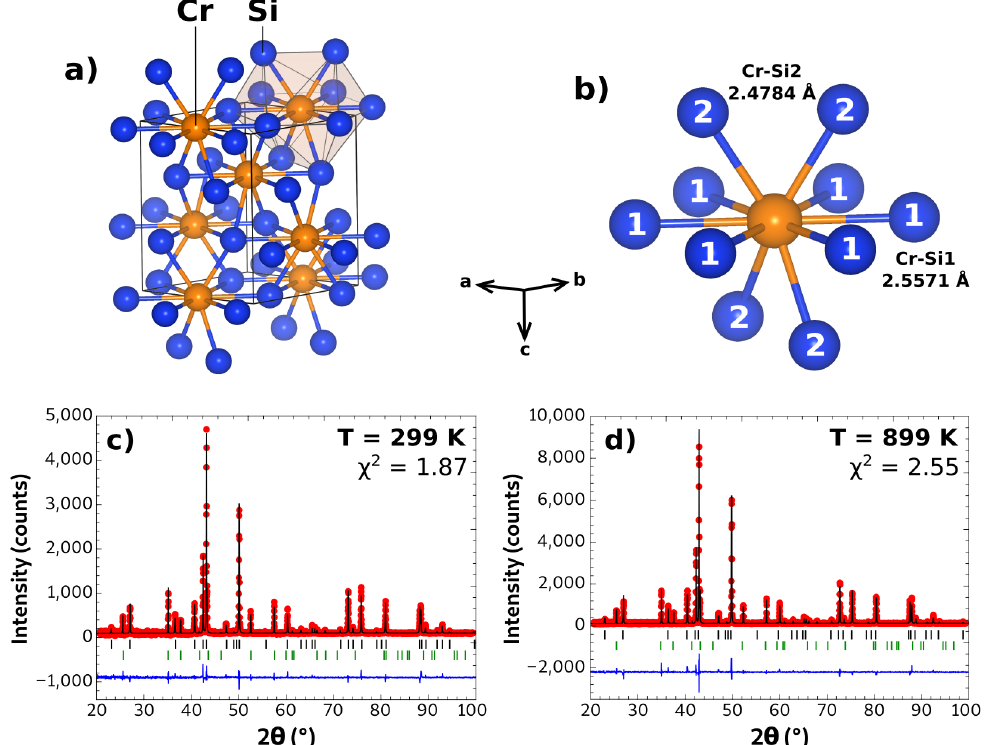
Figure 2. Scheme of the ( a ) crystal structure of CrSi 2 and ( b ) coordination environment around Cr with six intralayer Si1 and four interlayer Si2 atoms. Rietveld refined XRD patterns of CrSi 2 measured at ( c ) 299 K and at ( d ) 850 K. The experimental data were plotted in red symbols, the calculated pattern with a black line, and the difference with a blue line. The vertical ticks indicate the theoretical Bragg positions of CrSi 2 (black) and Al 2 O 3